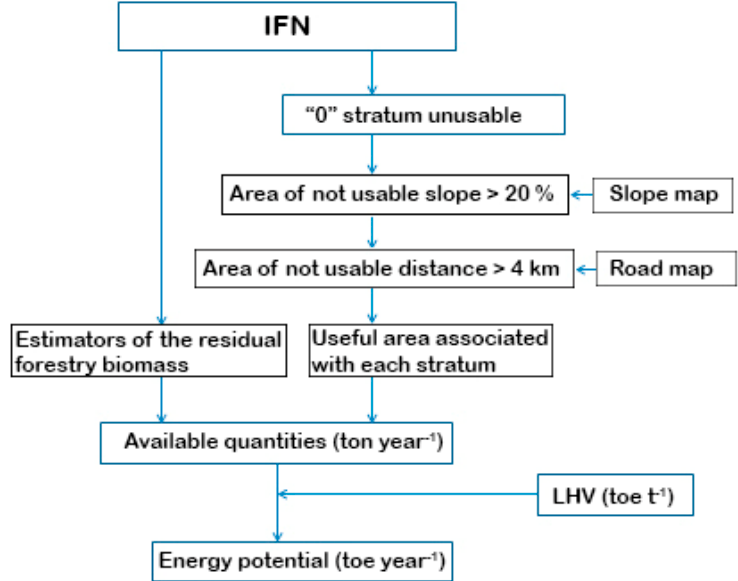
Figure 1. Methodology to estimate the energy potential from forest biomass.